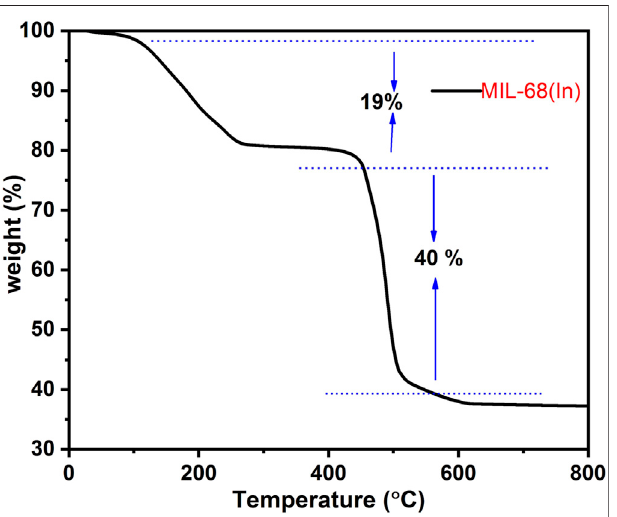
FIGURE 1 | TGA analysis of MIL-68(In).